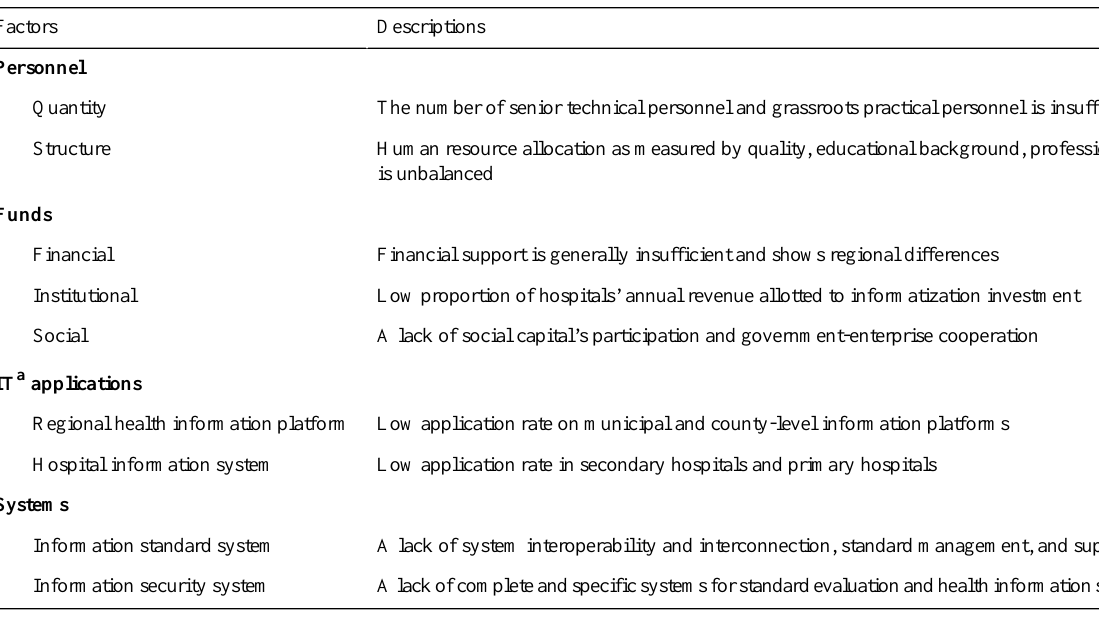
Table 1. Challenges to national health